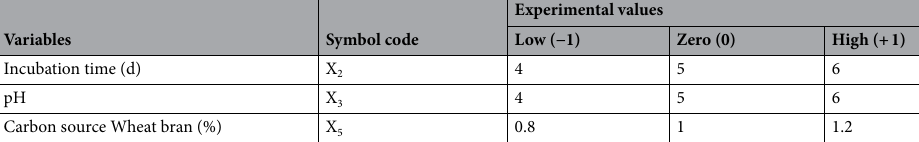
Variables Symbol